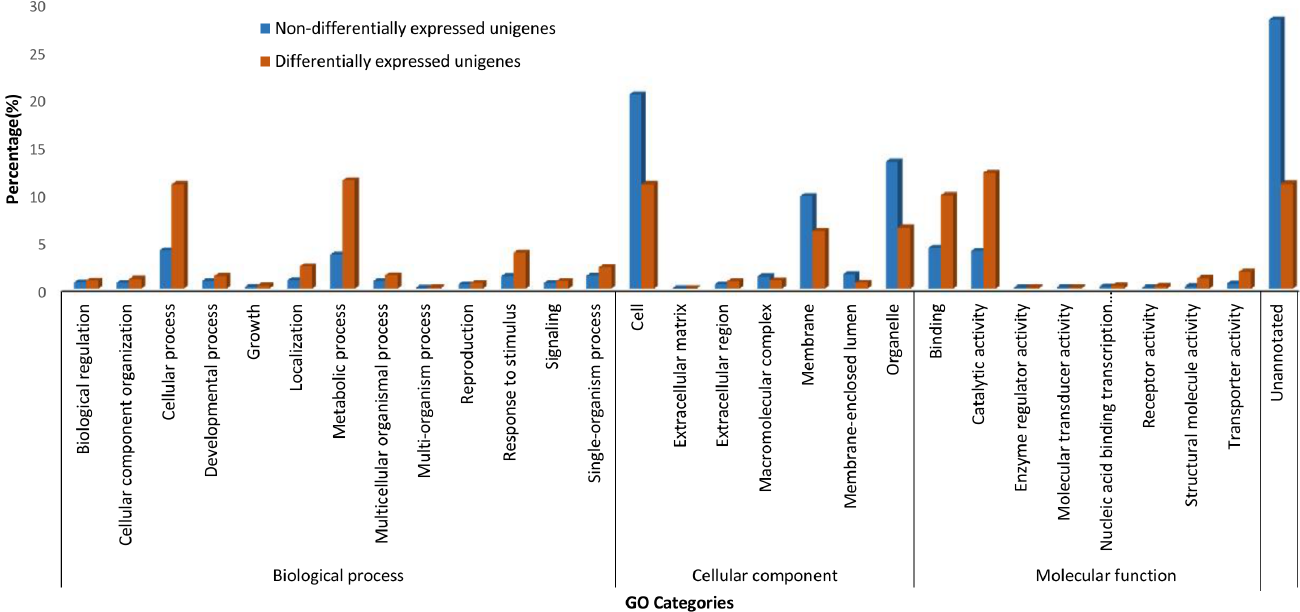
Fig 2. Gene Ontology (GO) assignments. GO assignment for the transcripts (unigene) differentially-expressed and non-differentially-expressed in the salt- stressed banana